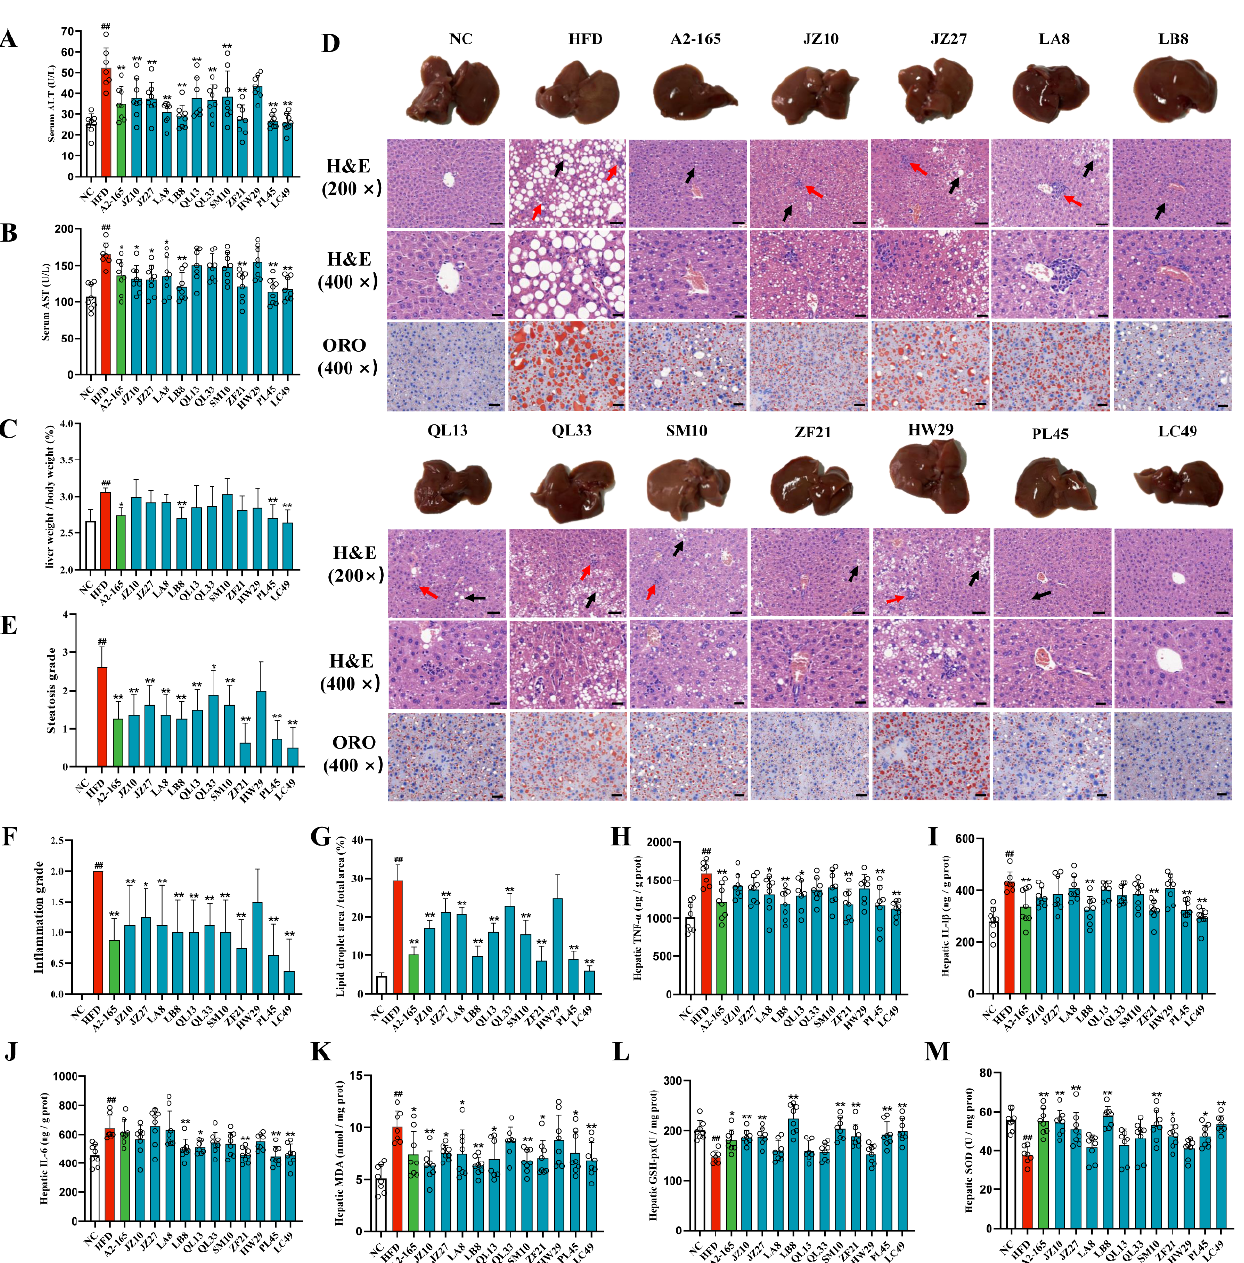
Figure 3. F. prausnitzii treatment prevented hepatic steatohepatitis and liver injury in NAFLD mice. ( A ) Serum ALT content; ( B ) Serum AST content; ( C ) Liver index; ( D ) Representative H&E and Oil red O stains of liver sections (scale bars represent 20 and 50 µ m for 400 × and 200 × , respectively), black arrow indicates lipid droplet, steatosis, and cytoplasmic vacuoles, and red arrow indicates lobular inflammation; ( E ) Steatosis grade; ( F ) Inflammation grade; ( G ) Quantification of Oil red O stained liver lipid droplets in ( D ); ( H – K ) Hepatic TNF- α , IL-1 β , IL-6, and MDA levels in different